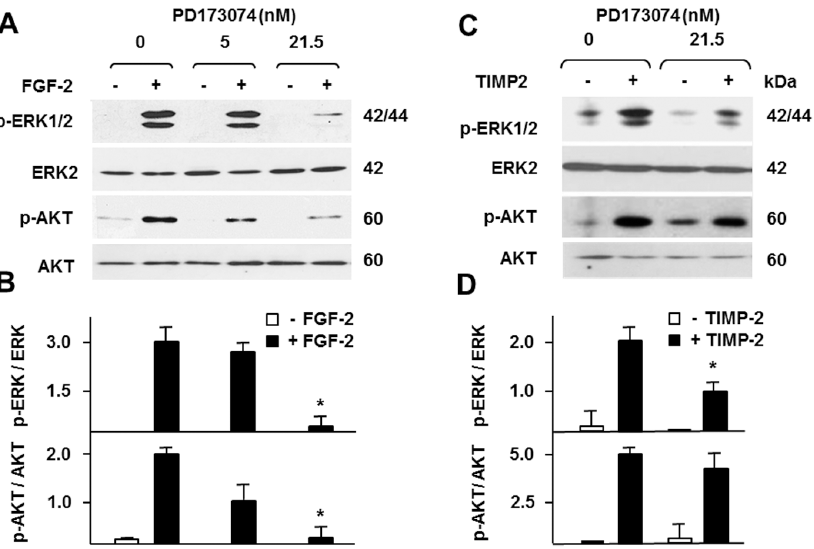
Fig 5. ERK1/2 but not AKT activation by TIMP-2/MT1-MMP is dependent on FGF receptor. Western blotting analysis of AKT and ERK1/2 activation (p-AKT; p-ERK1/2). MT1-MMP-expressing Tet-Off MCF-7 cells pretreated with the indicated concentrations of PD173074 or control vehicle (0) for 15 min were incubated with ( A ) recombinant FGF-2 (10 ng/ml; Akron Biotech, Boca Raton, FL, USA) or (C) TIMP-2 (100 ng/ml), or with control medium (-), for additional 15 min. B and D . Densitometric analysis of the blots shown in A and B, respectively. Total AKT and ERK2 are shown as loading controls. * , p (cid:1) 0.05, vs . the corresponding control with no PD173074. This experiment was repeated twice with comparable